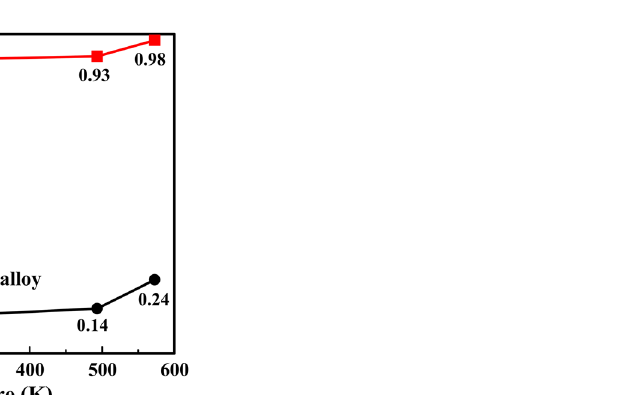
Figure 6. ( a ) and ( d ) Inverse pole figure (IPF) images of Al-Cu-Mg alloy and its composite before creep test respectively; ( b ) and ( e ) IPF images for Al-Cu-Mg alloy and its composite after testing at 493 K with 60 MPa; ( c ) and ( f ) IPF images for Al-Cu-Mg alloy and its composite after testing at 573 K with 60 MPa.